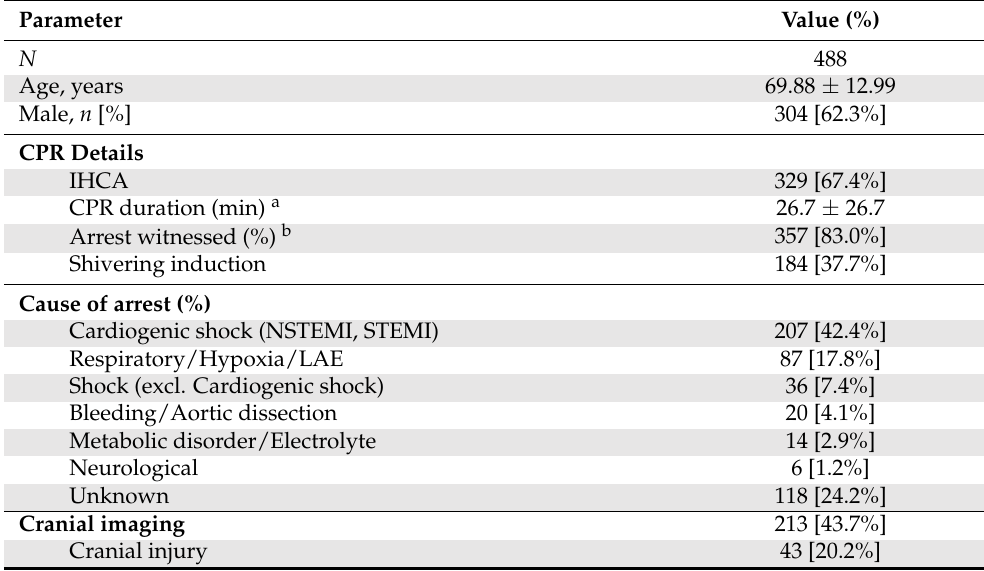
Table 1. Demographics of the CA patients treated at the University Clinic of Düsseldorf.